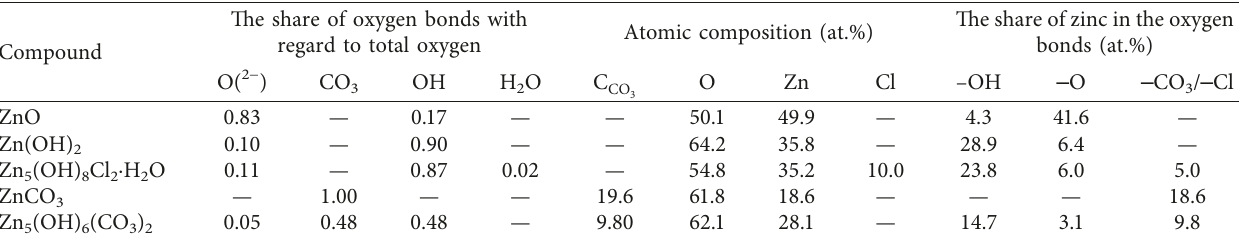
The share of zinc in the oxygen bonds